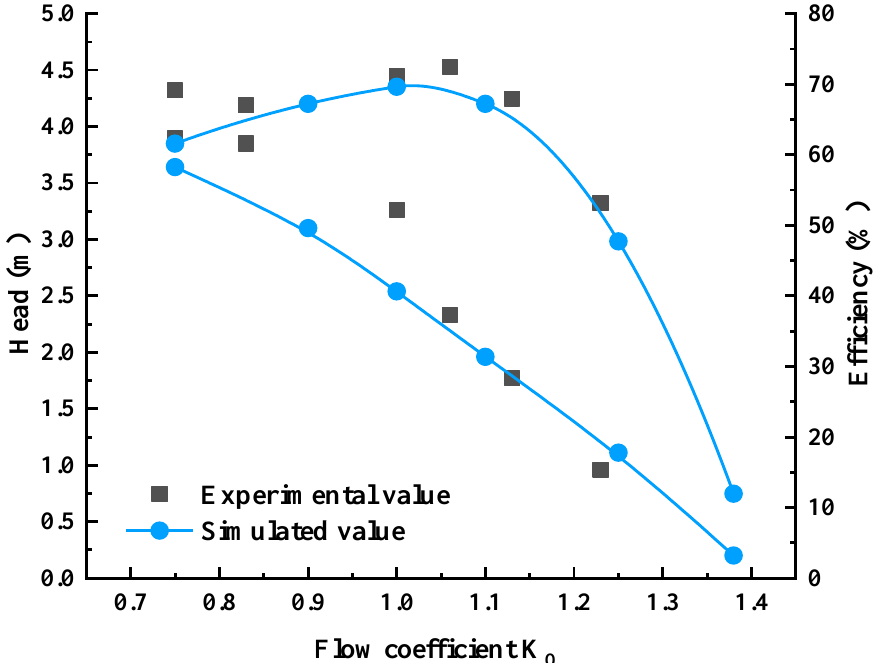
Figure 8. Numerical simulation and test hydraulic performance comparison.